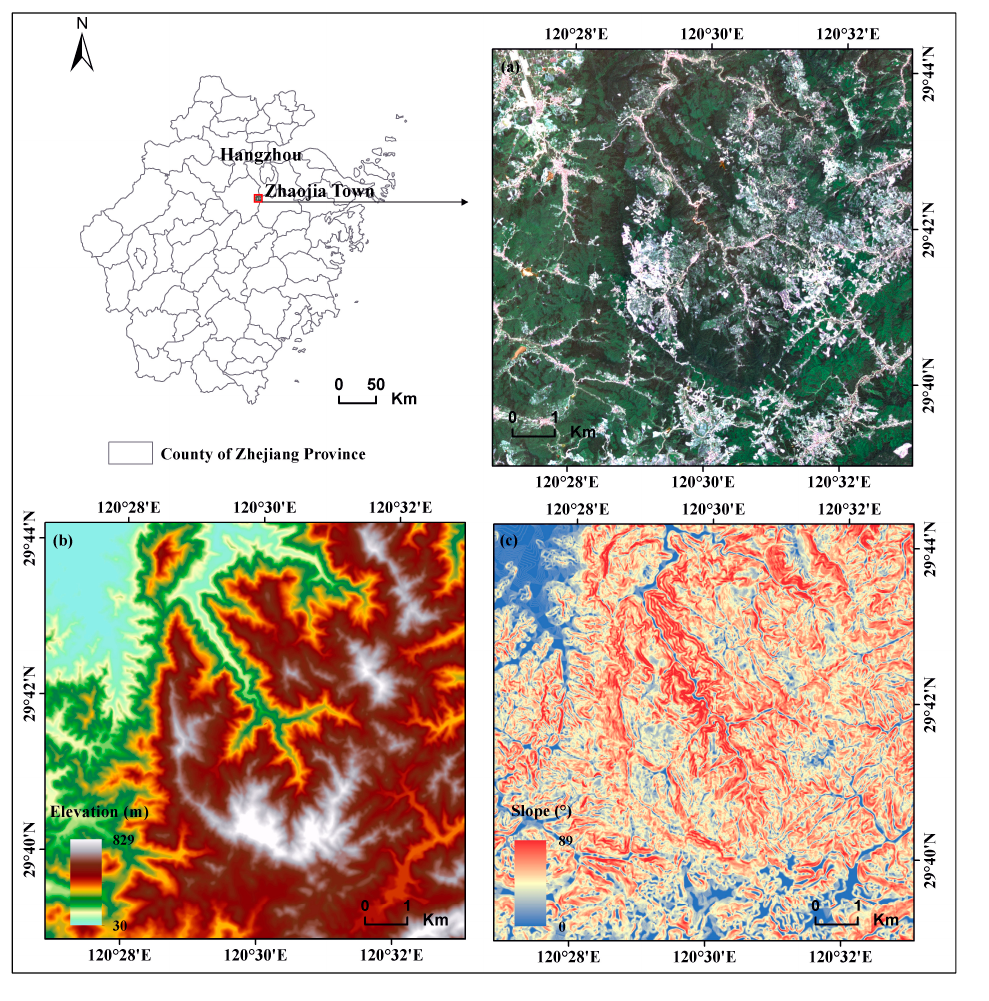
Figure 1. Location of the study area—northern Zhaojia Township, Zhuji County, Zhejiang Province. ( a ) represents true color composite of a Chinese Gaofen (GF-1) fused image; and ( b , c ) represent elevation and slope of the study area.